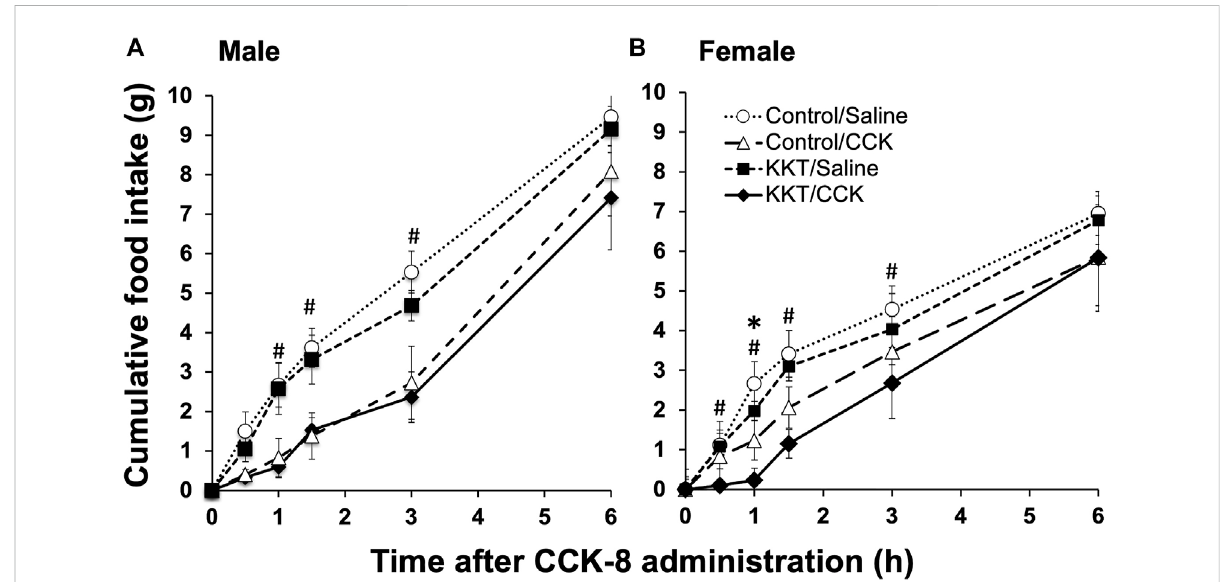
FIGURE 5 Endogenous oxytocin-monomeric red fl uorescent protein 1 (OXT-mRFP1; red), Fos-immunoreactive (-IR) cells (green) and the merged image oftheparaventricular nucleus (A) and supraopticnucleus (SON) (B) .Sections wereobtained 90 min after intraperitoneal cholecystokinin-8 injection for the male control group (MC), male KKT-treated group (MK), female control group (FC), and female KKT-treated group (FK) (MC: n = 6, MK: n = 6, FC: n = 4, FK: n = 5). Fos IR cell were counted in the parvocellular paraventricular nucleus (pPVN), magnocellular paraventricular nucleus (mPVN), and the SON region (C-a) . Cells expressing both nuclear Fos-IR and cytoplasmic OXT-mRFP1 were counted (C-b)